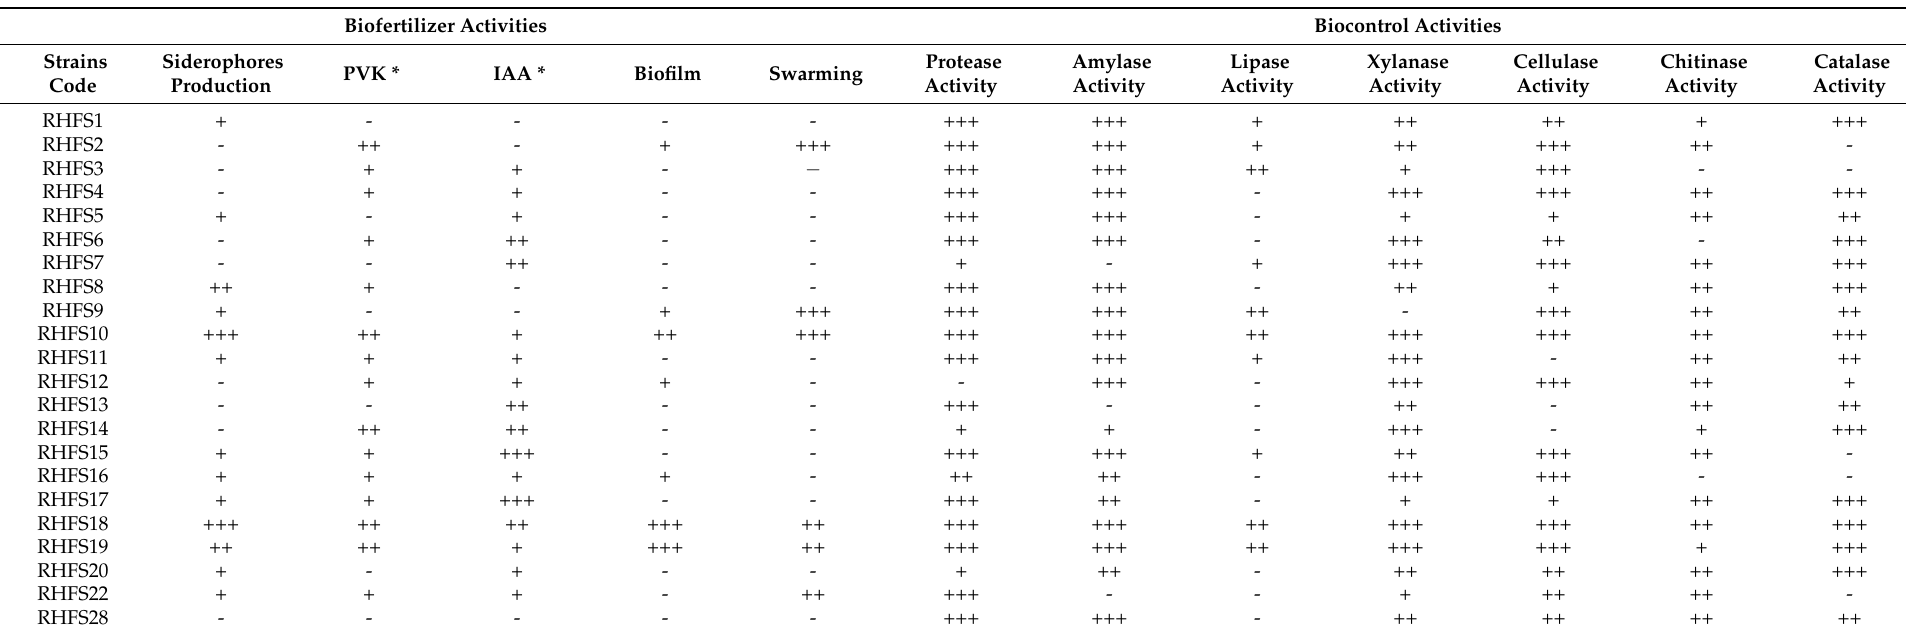
Table 1. Summary of plant growth-promoting and biocontrol traits exhibited by 22 spore-forming bacteria